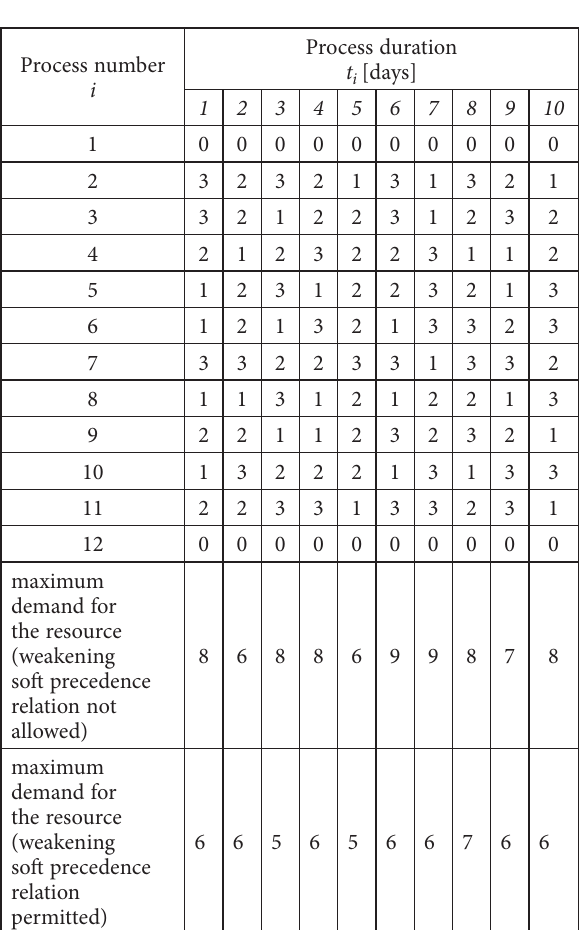
Table 3. Input and the results of 10